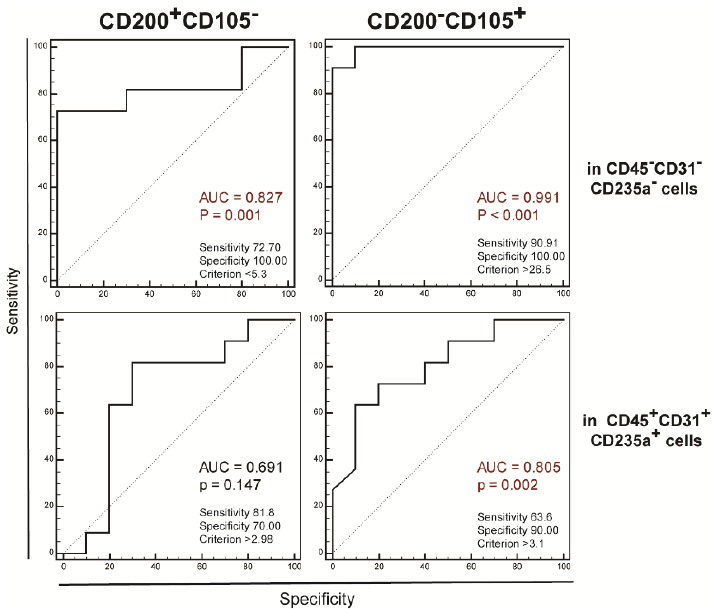
Figure 3. Ability of proportions of CD200 + CD105 − and CD200 − CD105 + populations to discriminate between RA patients and controls was assessed by receiver operating characteristic (ROC) curves showing discriminatory ability of proportions of CD200 + CD105 − and CD200 − CD105 + amongst non-hematopoietic ( upper panels ) and hematopoietic ( lower panels ) cells between arthritic and control samples. Sensitivity, specificity, criterion point, p value, and area under curve (AUC) are shown on